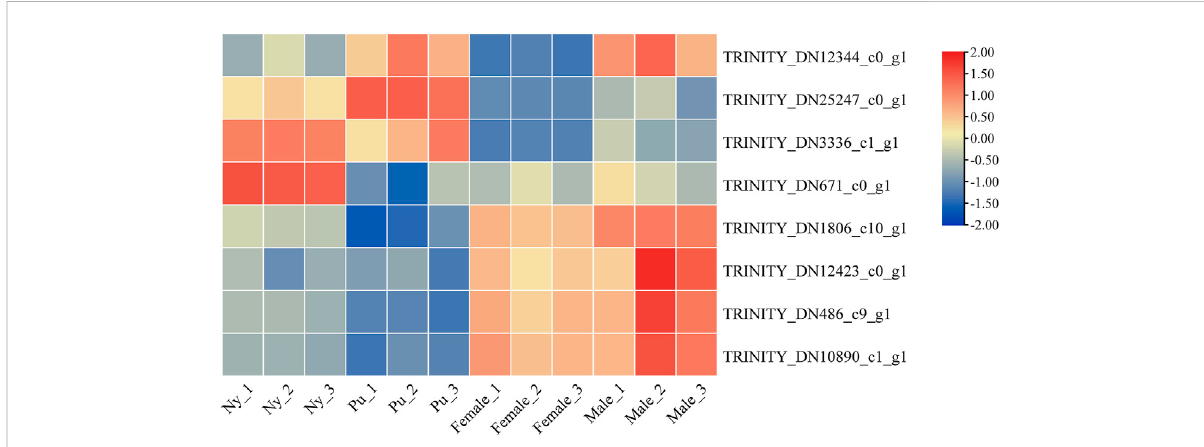
FIGURE 1 Cluster diagram of OBP and CSP gene expression at different developmental stages.